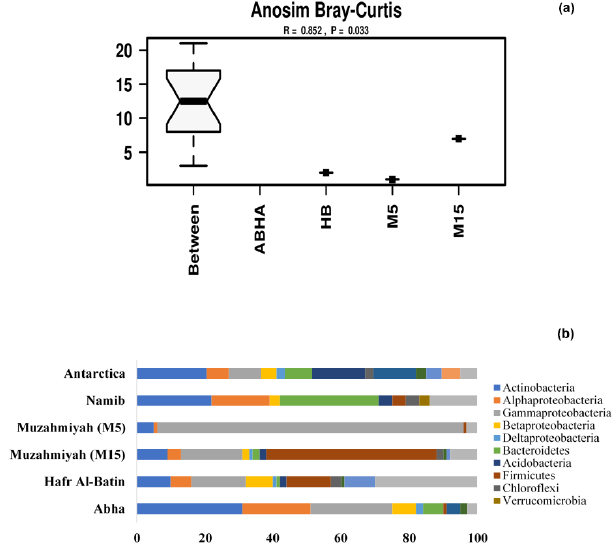
Figure 3. Analysis of similarity (ANOSIM) within and between samples (a) . The abundance of different phyla in desert soil sam- ples studied and their comparison with the hot (Namib) and cold (Antarctica) desert samples are shown in (b) . Data for Antarctic desert and Namib desert are taken from Armstrong et al. (2016) and Cary et al. (2010),